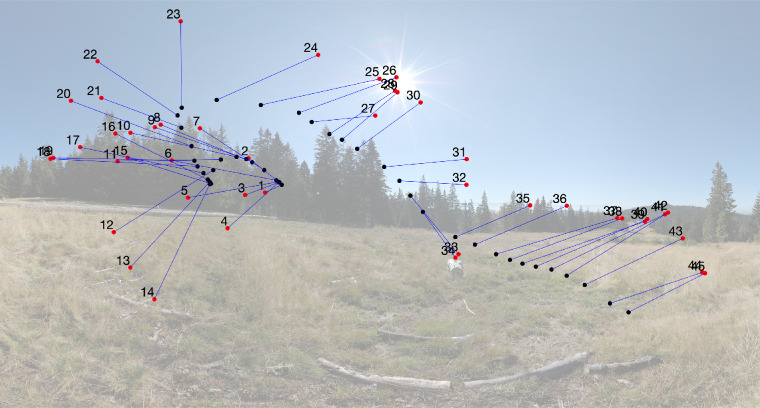
Example of (gaze) fixations and the corresponding head fixations. The red circles show a sequence of fixations (numbered from 1 to 45). The black circles show the head fixations during each fixation, and the lines connect the two.